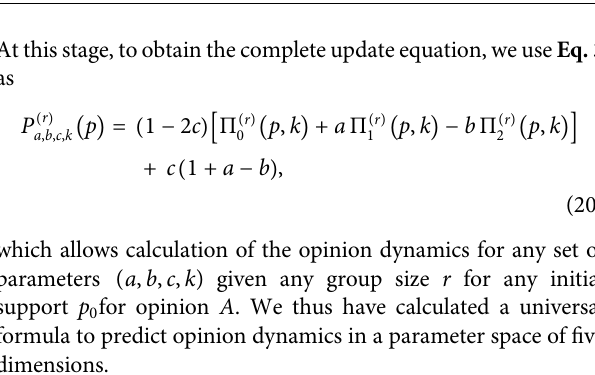
FIGURE 1 | Diagrams representing a group of r agents made up of α A -in fl exibles (shown as A ), β B -in fl exibles (shown as B ), and r α − β fl oaters and contrarians. Agents are split into two opinions with μ having one opinion and ( r − μ ) being the other with μ < [ r / 2 ] . The left diagram is the case in which opinion A holds the majority, and the right diagram is the case in which B holds the